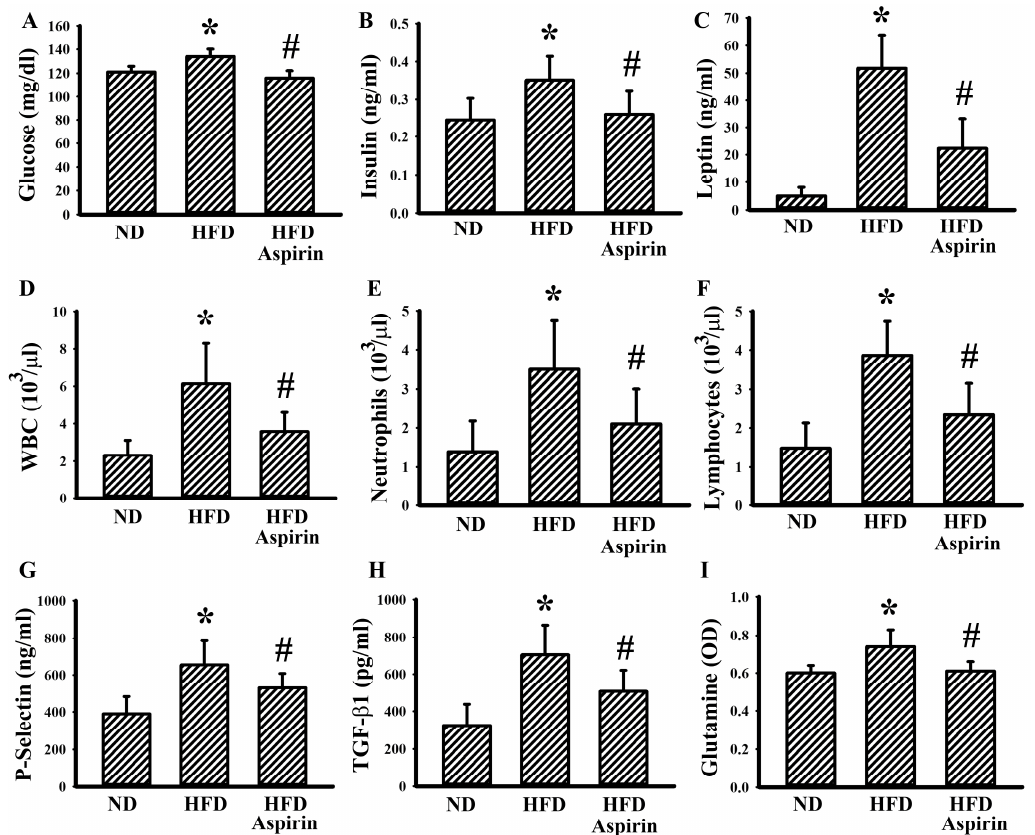
Figure 4. Aspirin improved metabolic alterations in obese mice. LLC cells (LLC) were implanted